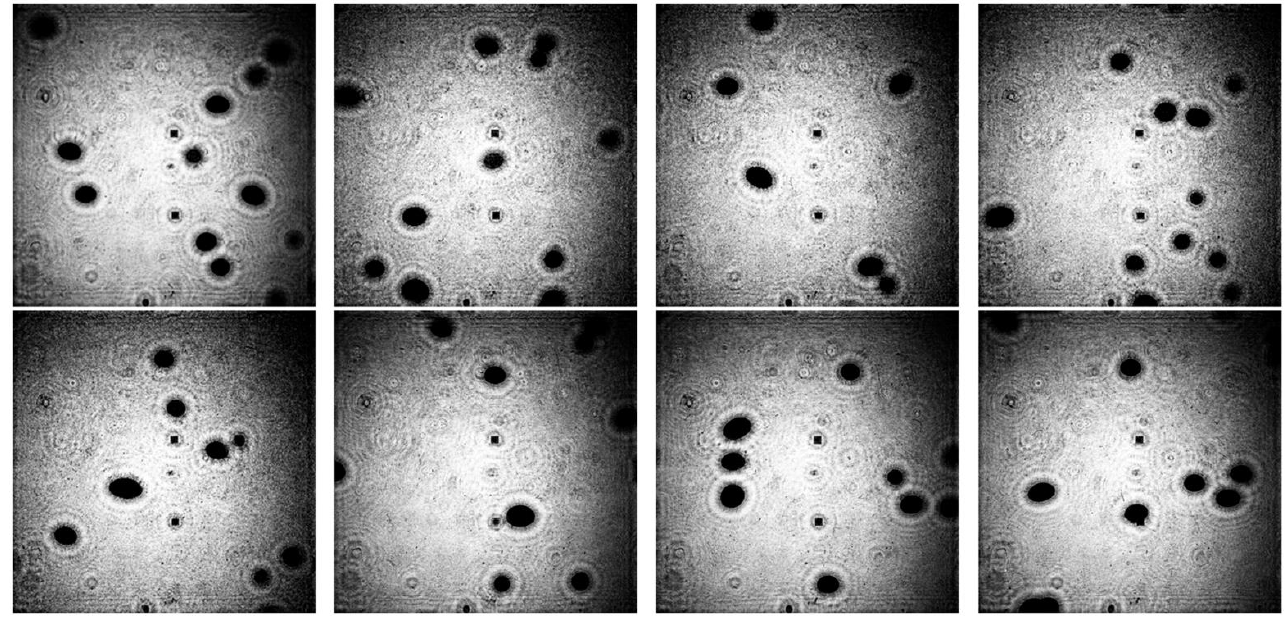
Figure 7. A 2D display of holographic images of the water volume with bubbles.